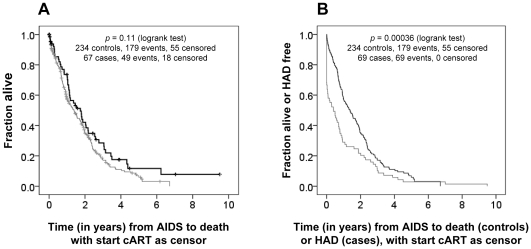
Comparison of AIDS survival between HAD cases and non-HAD controls.(A) Kaplan Meier analysis for time from AIDS to death with start cART as censor (vertical lines), for both HAD cases (grey line) and non-HAD AIDS patients as controls (black line). (B) Kaplan Meier analysis for time from AIDS to death with start cART as censor (vertical lines) for the controls (black line) and for time from AIDS to HAD for the HAD cases (grey line). cART, combination antiretroviral therapy; HAD, HIV-1-associated dementia.